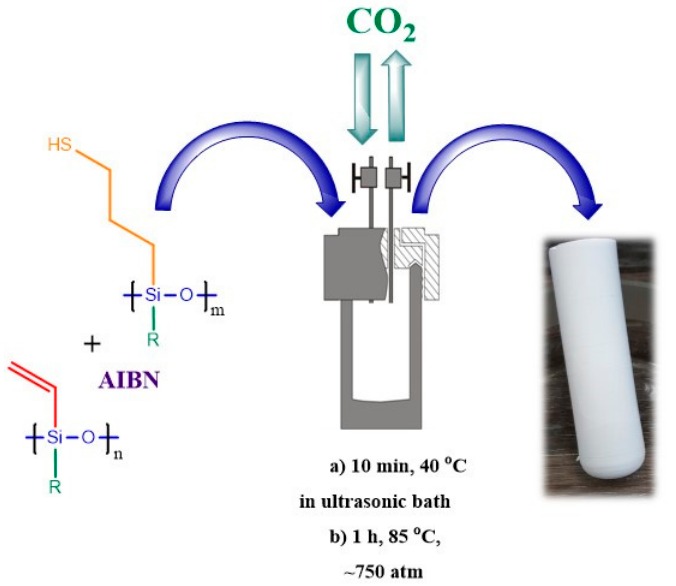
Figure 42. A schematic representation of aerogel preparation directly in sc-CO 2. Reproduced with permission from Ref. [163]. Copyright (2018), with permission from